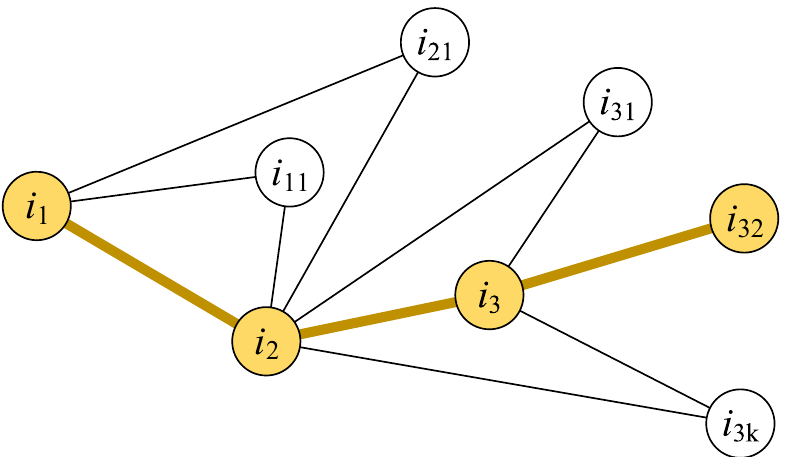
Figure 3. Illustration of the long-line screening mode. The yellow nodes are selected persons who are screened, and the yellow lines between nodes expresses the contact path between persons.